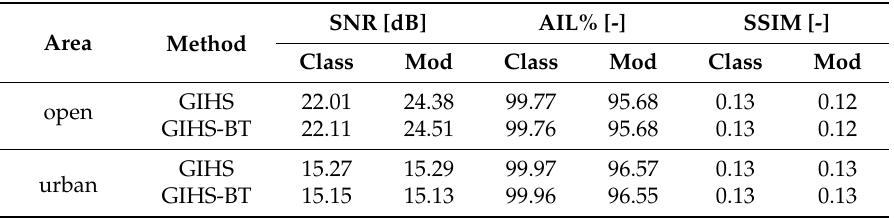
Table 5. Quality assessment indices for the fusion of Landsat 8 OLI and WorldView-2 imagery data using the classical (class) and modified (mod)